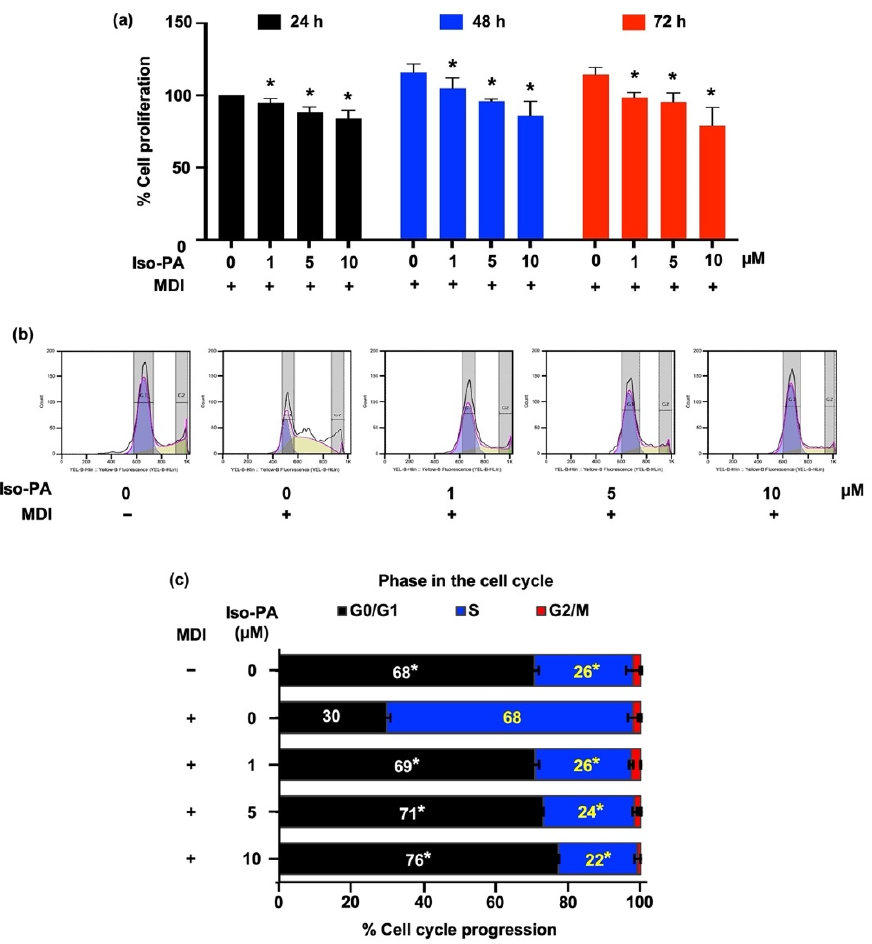
Figure 3. Effects of isopanduratin A on cell proliferation and cell cycle progression of differentiated 3T3-L1 cells. ( a ) A crystal violet assay was used to track the proliferation of cells cultured in differentiation medium with or without 1–10 µ M isopanduratin A for 24 to 72 h. The alteration of the cell cycle in cells treated with isopanduratin A was evaluated by flow cytometry and presented in ( b ) histograms and ( c ) cell frequency in each phase. Confluent 3T3-L1 cells were cultured in the presence (+) or absence ( − ) of differentiation medium (MDI) with 0–10 µ M isopanduratin A (Iso-PA). Cells treated with dimethyl sulfoxide (0.5% v / v ) functioned as the untreated control (0). Bar graphs demonstrating mean ± SD (n = 3) were created using GraphPad Prism. A one-way ANOVA with Tukey’s post hoc test was used to compare the means of treatment and the differentiated control groups (* p < 0.05) .